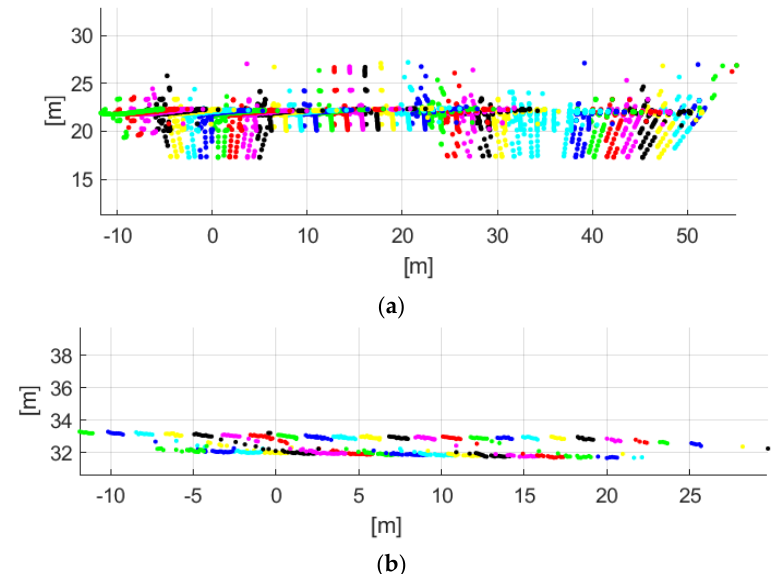
Figure 3. Top ‐ down views from an airplane captured at different times by the sensor network. The two subfigures illustrate the point densities at different object–sensor distances: color differentiates scans: ( a ) at 23 m object–sensor distance, the average number of points per scan is 130 (26 per sensor), and ( b ) at 33 m object–sensor distance, the average number of points per scan is 20 (4 points from each sensor).